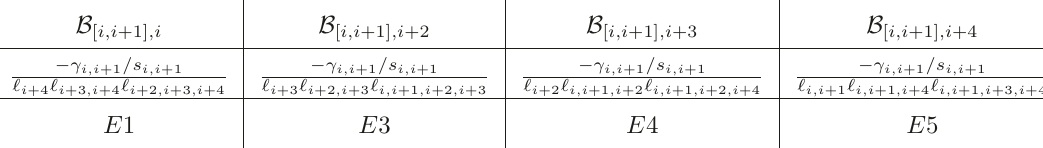
Table 2 . Final results for the box diagrams, i ∈ [1 , 5]. Like in table 1, the first and the second lines show the terms and their respective final expressions, while in the last line their corresponding forward-limit channels are given and the cut lines are depicted in figure 10. Again, for a given cut line in the Q-cut analysis, its momentum is chosen to be ℓ .